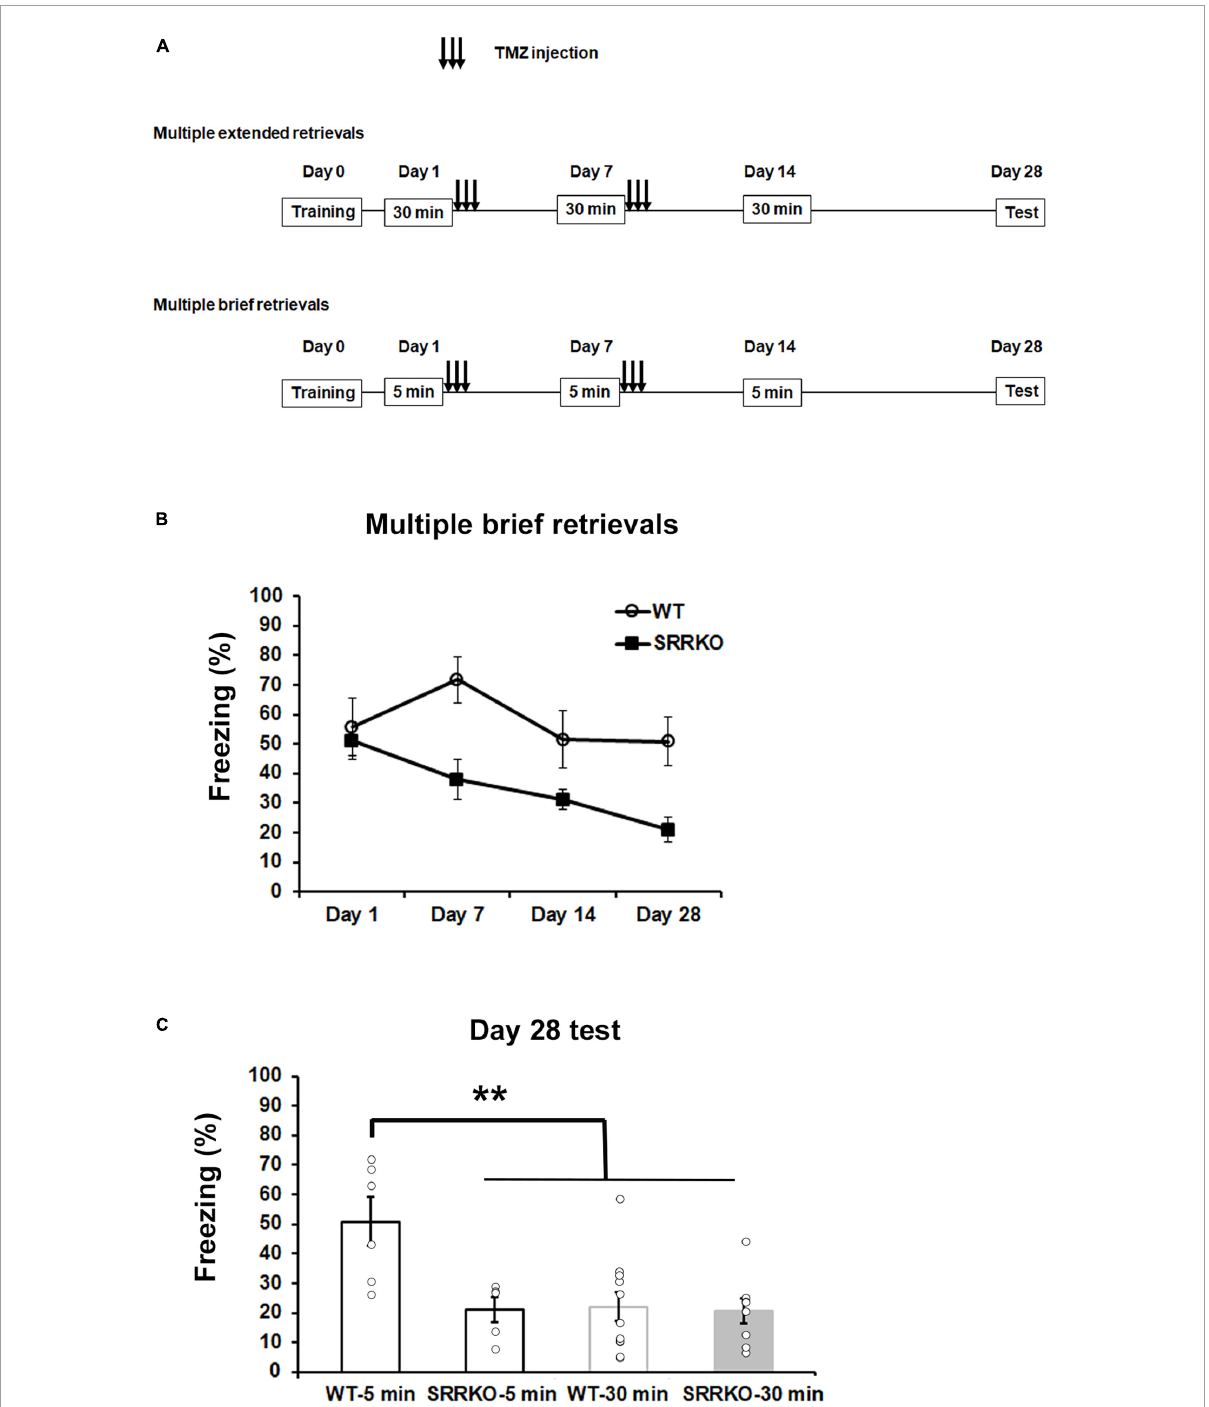
FIGURE5 Effects of blockade of D -serine signaling and hippocampal neurogenesis on remote fear memory following extended and brief retrievals. (A) Experimental schedule for contextual fear conditioning, multiple retrievals, and TMZ treatment. Two different protocols, extended retrievals with 30 min re-exposure (as an extinction procedure) and brief retrievals with 5 min re-exposure, were used. (B) During the course of four brief retrievals on day 1, 7, 14, and 28, TMZ-treated SRRKO mice exhibited significantly lower freezing levels compared to TMZ-treated WT mice (WT, n = 6; SRRKO, n = 5). (C) During the remote test on day 28, WT mice receiving brief retrievals (WT-5 min, n = 6) exhibited a significantly higher freezing level compared to the other three groups, SRRKO mice receiving brief retrievals (SRRKO-5 min, n = 5), WT mice receiving extended retrievals (WT-30 min, n = 11), and SRRKO mice receiving extended retrievals (SRRKO-30min, n = 8). Data are presented as the means ± SEM. ** p <